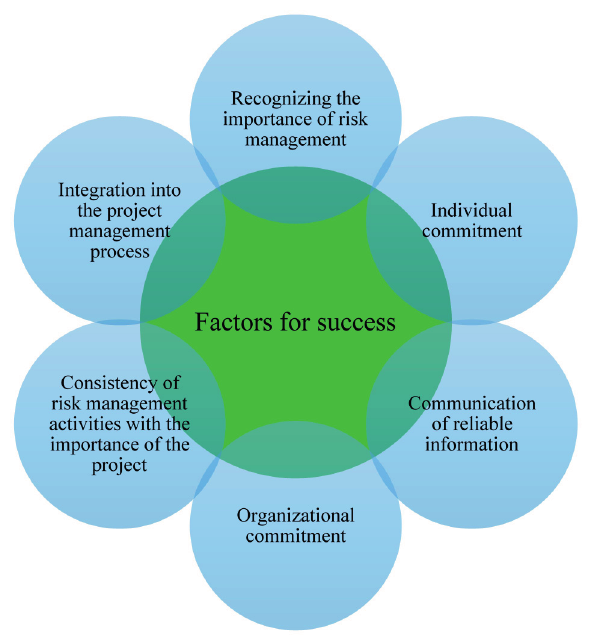
Figure 6. Factors that contribute to successful risk management. Based on